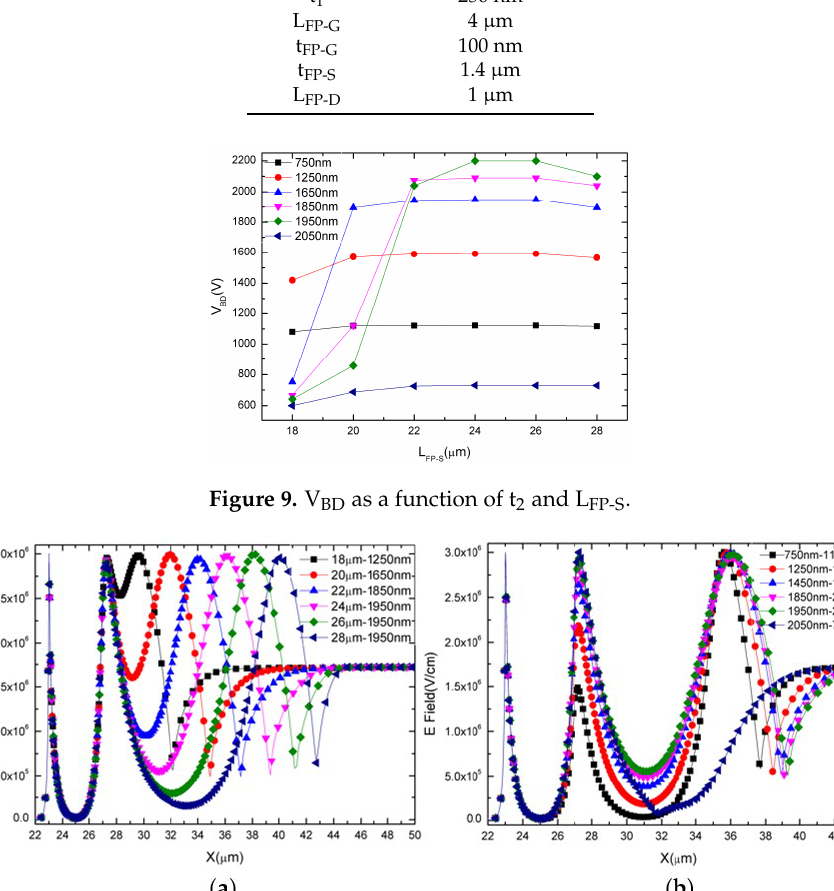
Figure 10. ( a ) The electric field distributions along the channel in HEMT with different L FP-S under highest V BD ; ( b ) the electric field distributions along the channel in HEMT when L FP-S = 24.